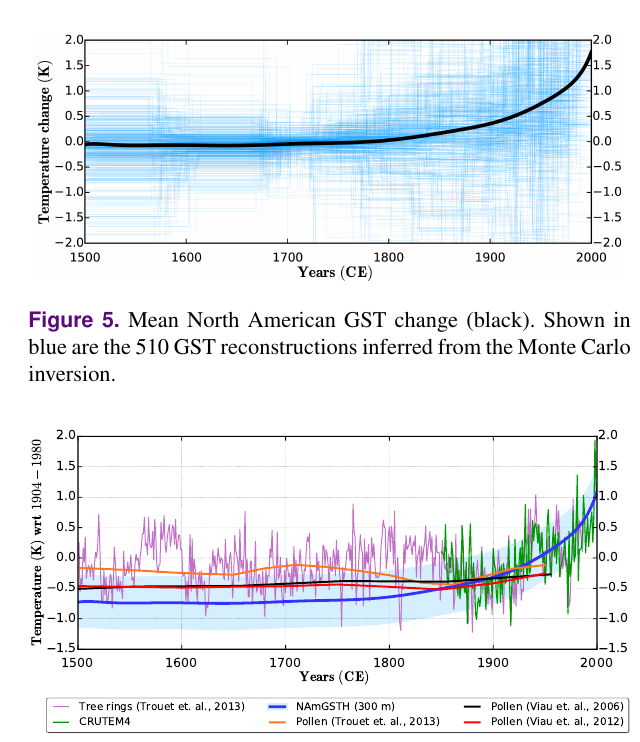
Figure 6. Mean North American GST history (blue) and maximum temperature range of accepted models ( ∼ 0.44K) obtained from the Monte Carlo method (blue shade). Also shown are proxy-based SAT reconstructions for North America from 1500 to 2000 CE. All anomalies are displayed as departures from the 1904–1980